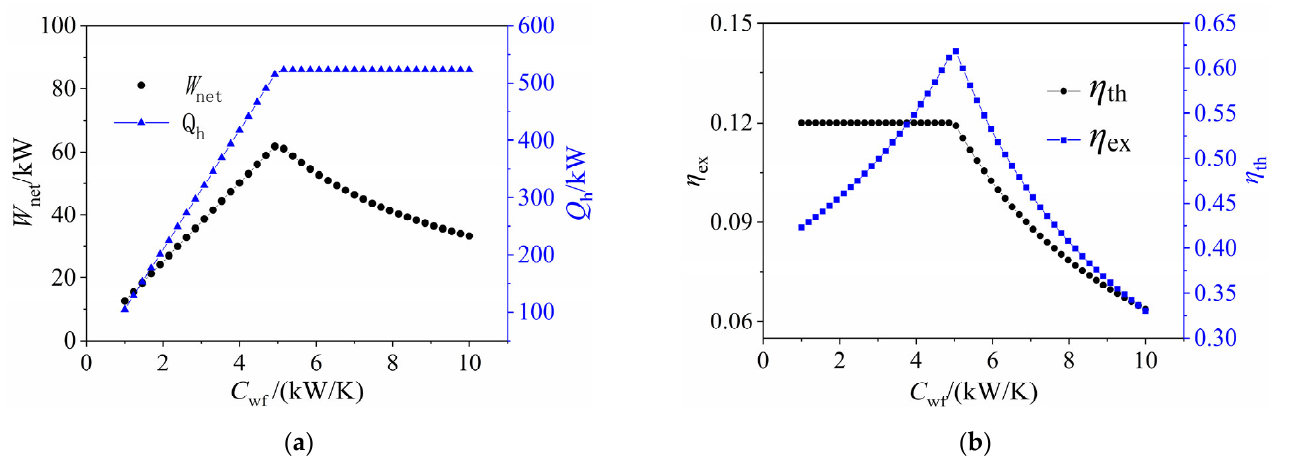
Figure 5. The impact of C wf on the thermal performance of the system for a constant ε : ( a ) Q h and W net ; ( b ) η th and η ex.